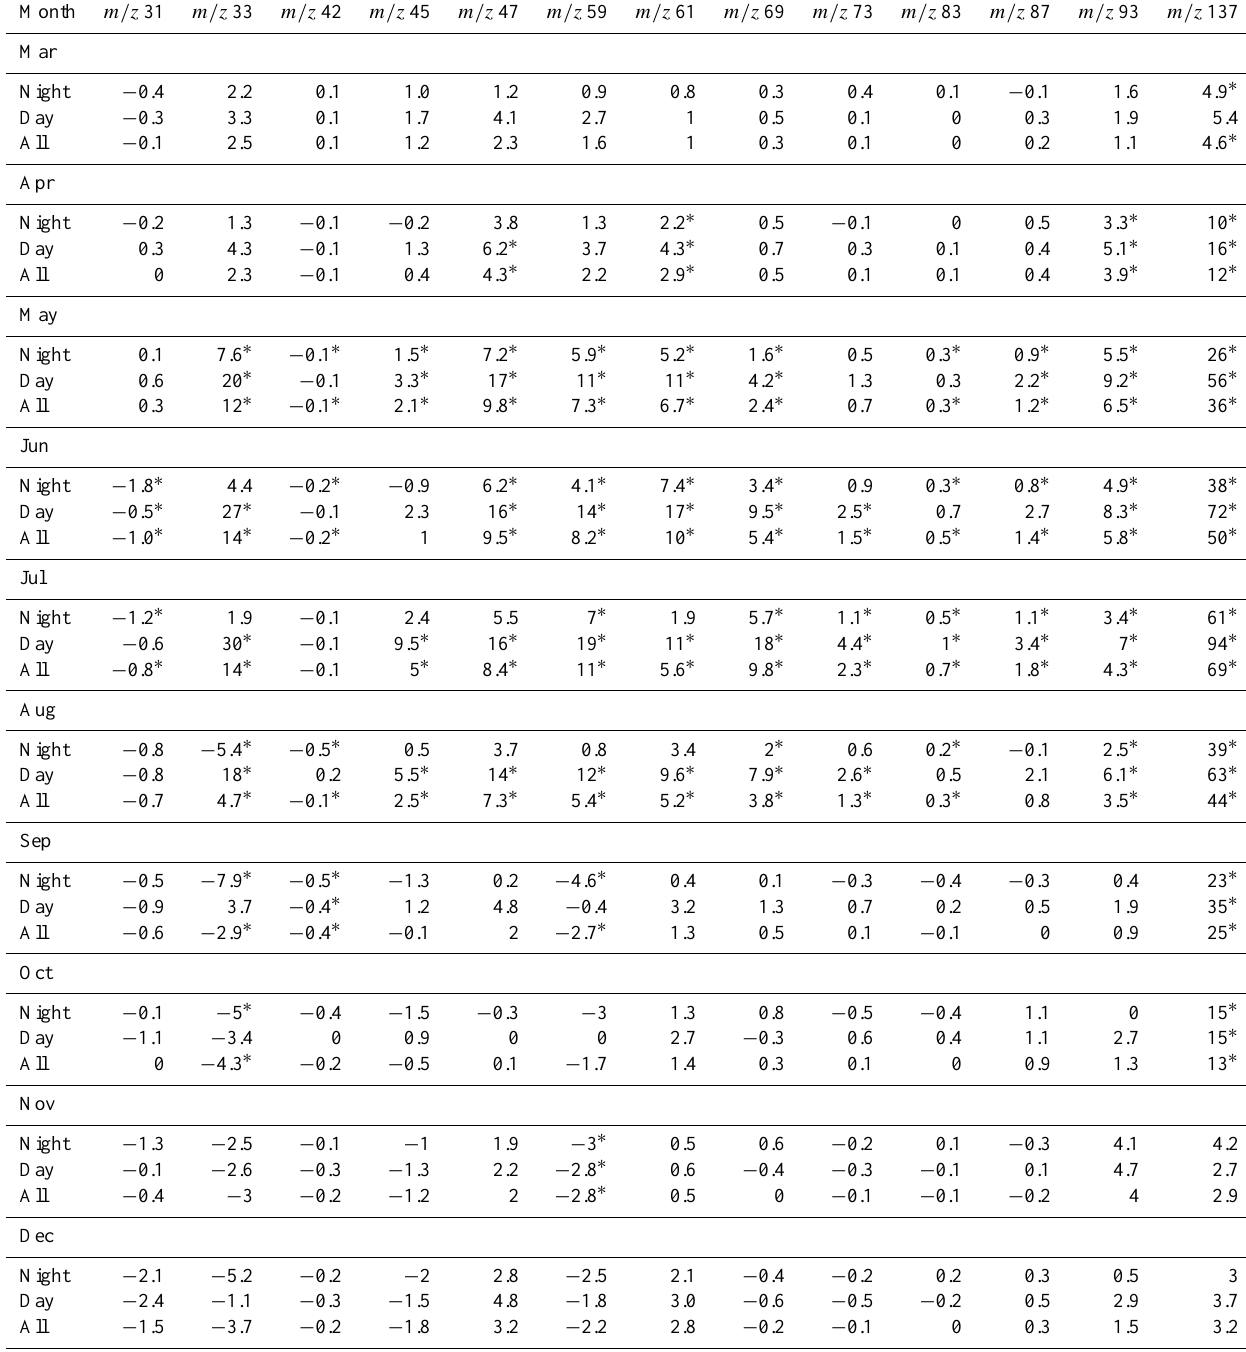
Table 2. The table includes daytime, night-time, and diurnal flux averages (arithmetic) for each month (years 2010–2013). The values are expressed with two significant numbers but with a maximum of one decimal. Significant (4 σ ) averages are marked with an asterisk ( ∗ ). A diurnal average was defined to be statistically significant if either a daytime value or the night-time value differed statistically from zero. The fluxes have unit of ngm − 2 s − 1